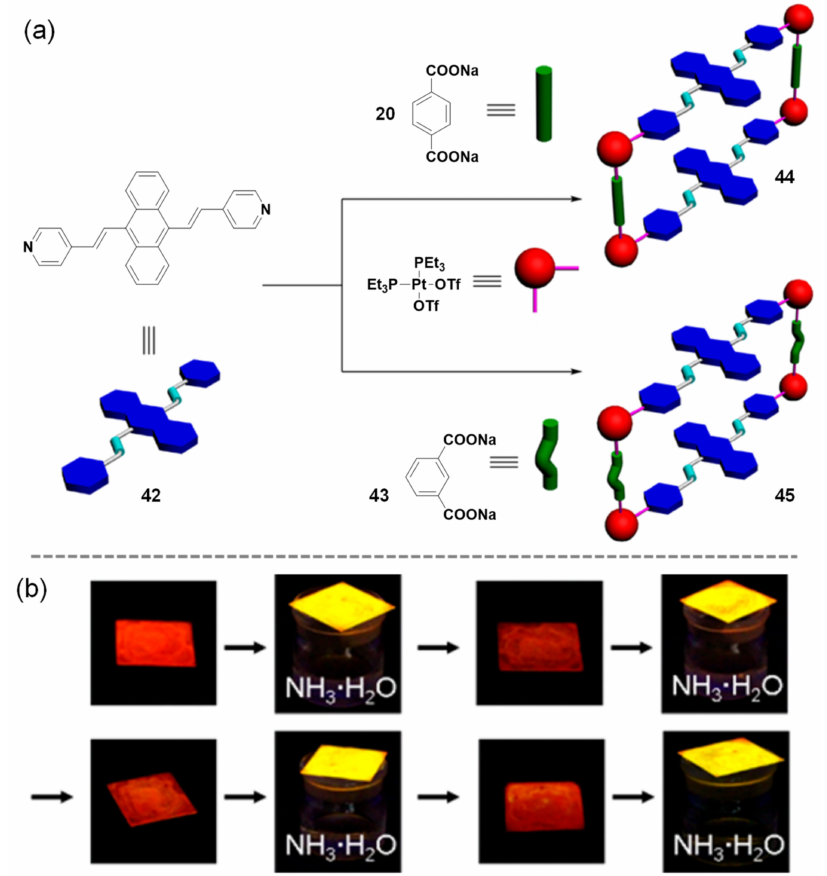
Figure 10. Near-infrared emissive discrete platinum(II) metallacycles. ( a ) Synthesis of metallacycles. ( b ) Photographs of films of 44 when exposed to or removed from ammonia under a UV lamp at 365 nm. Reprinted with permission from Ref. [91]. Copyright 2017 American Chemical